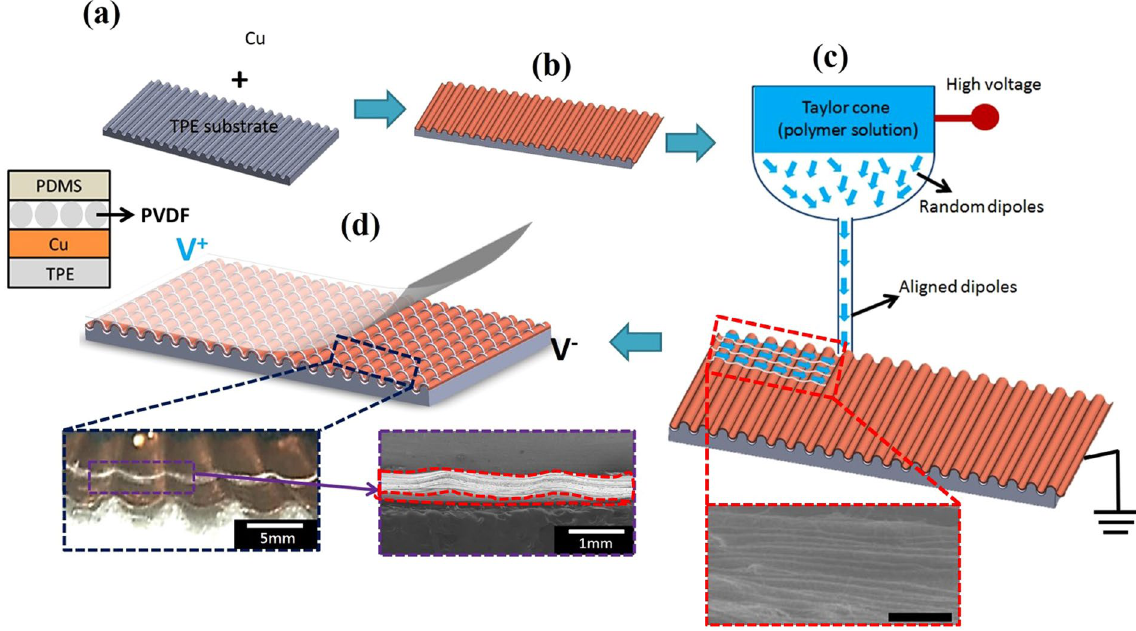
Figure 1. ( a ) Schematic of the near-field electrospinning process to fabricate direct-write PVDF fibers on top of wavy substrate. ( b ) Mechanical adhesion of wavy substrate with Cu foil as conductive electrode. ( c ) Electrospun PVDF fibers on top of Cu-adhesive wavy substrate via NFES. ( d ) Fully encapsulation with PDMS (bottom inset: optical photo and SEM image of PVDF fibers deposited on top of wavy substrate, exhibiting the wavy and 3D topology). Scale bar is 200 μ